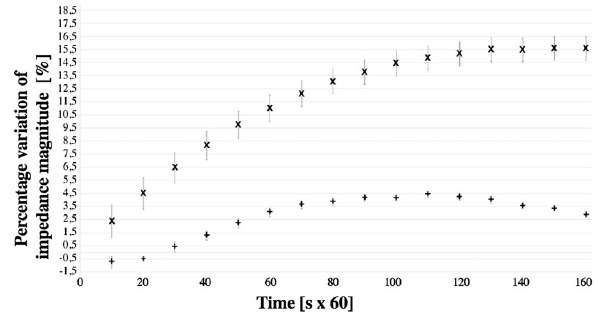
Figure 4. Dried eggplant drift in 2-( × ) and 4-wire ( + ) configuration (average on 10